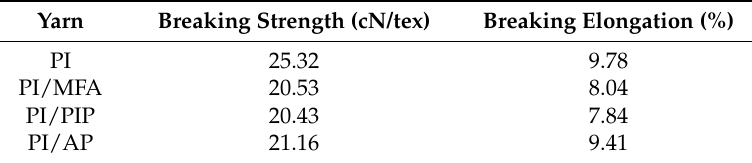
Table 2. Tensile properties of PI yarns treated with swelling agents.